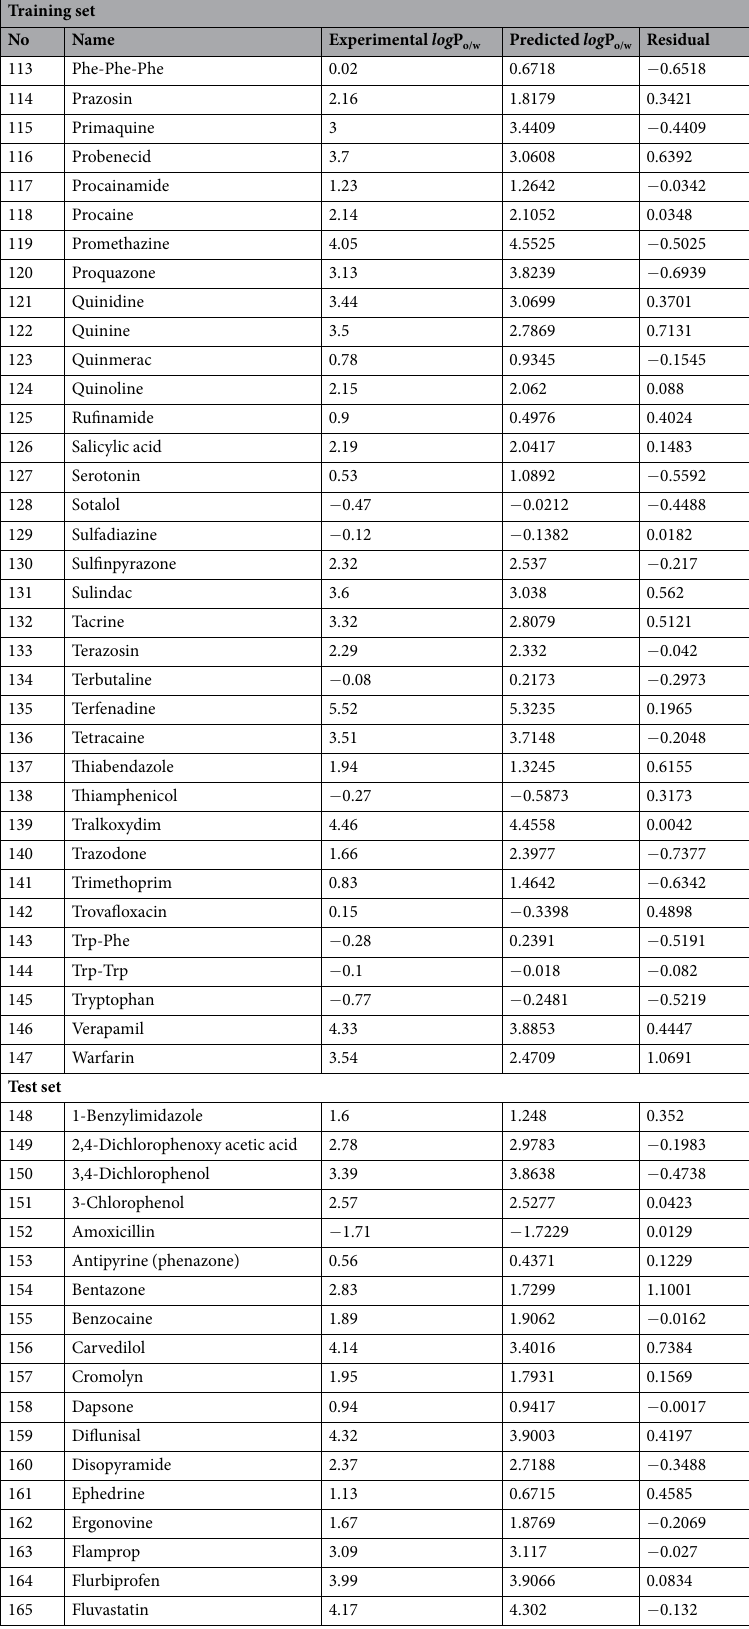
Table 1. Experimental log P o/w , Predicted log P o/w and Residuals values for train and test set of Aromatic Drugs for MLR